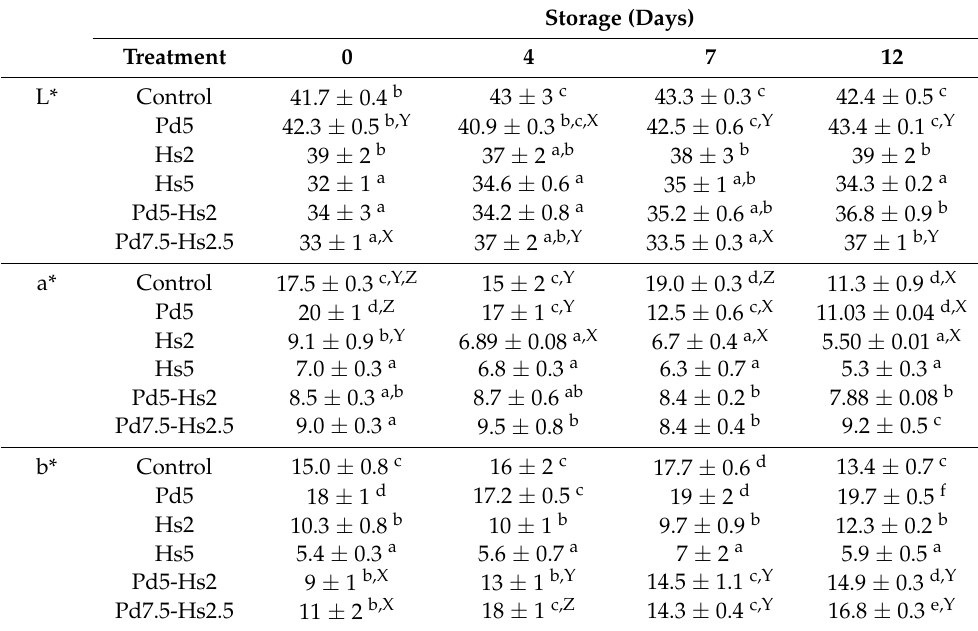
Table 4. CIELab color parameters from different beef patty